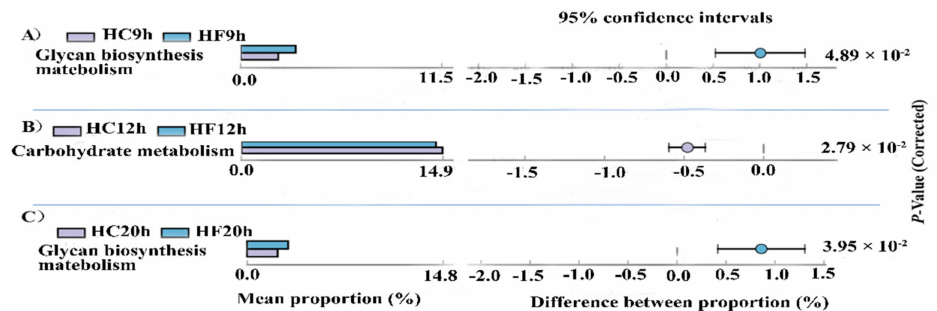
Figure 6. ( A ) The abundance ratio of glycan biosynthesis metabolism between the HF9handHC9h. ( B ) The abundance ratio of carbohydrate metabolism between the HF12handHC12h. ( C ) The abundance ratio of glycan biosynthesis metabolism between the HF20h and HC20h. Phylogenetic Investigation of Communities by Reconstruction of Unobserved States (PICRUSt) analysis. Variance analysis of the Kyoto Encyclopedia of Genes and Genomes (KEGG) metabolic pathways in the second level. The graphs show the abundance ratio of di ff erent functions in two groups of samples. The middle shows the di ff erence between the proportions of functional abundance in the 95% confidence interval, and the value at the rightmost is the p -value. p < 0.05 represents the significant di ff